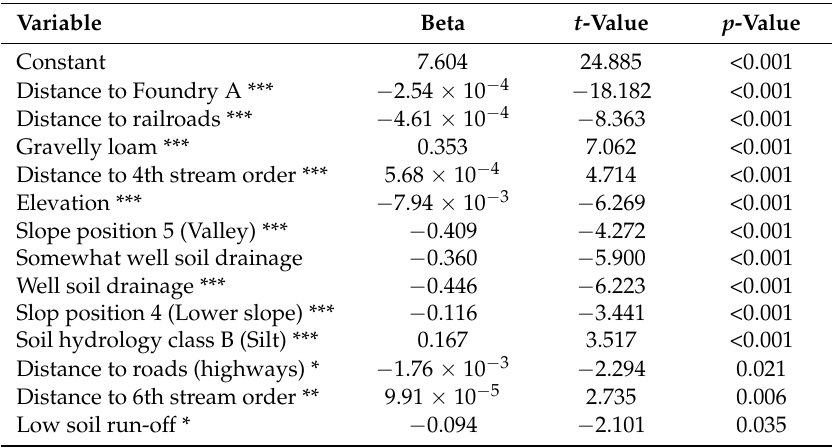
Table 3. Estimated results of regression models of pollution hazard intensity, as a function of physical profiles; Ordinary least squares (OLS) regression. Model 1. OLS Regression Model for Physical Variables- R 2 = 0.380